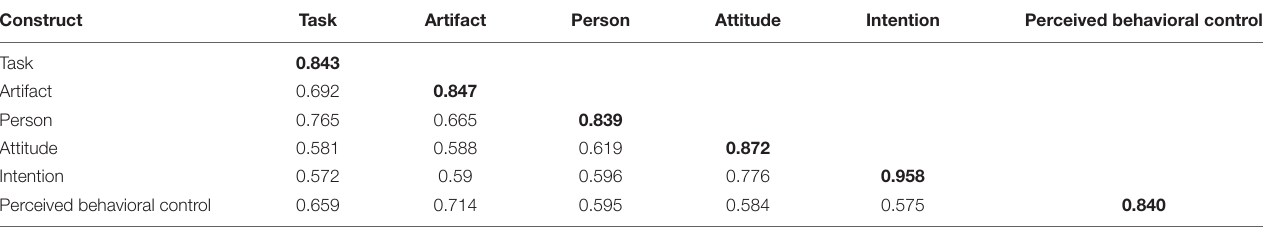
TABLE 4 | Simple correlation matrix and discriminatory